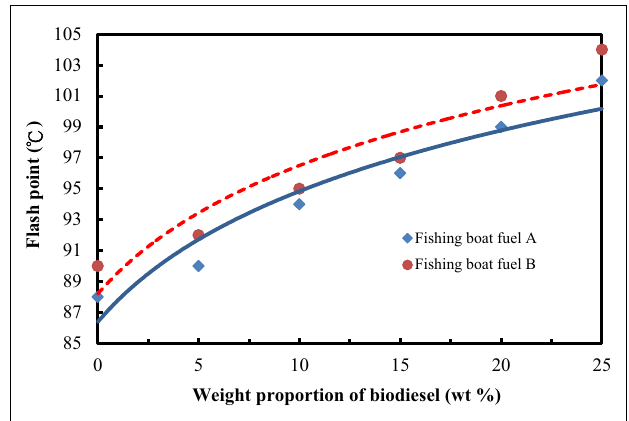
42.042.543.043.544.044.545.045.546.046.5